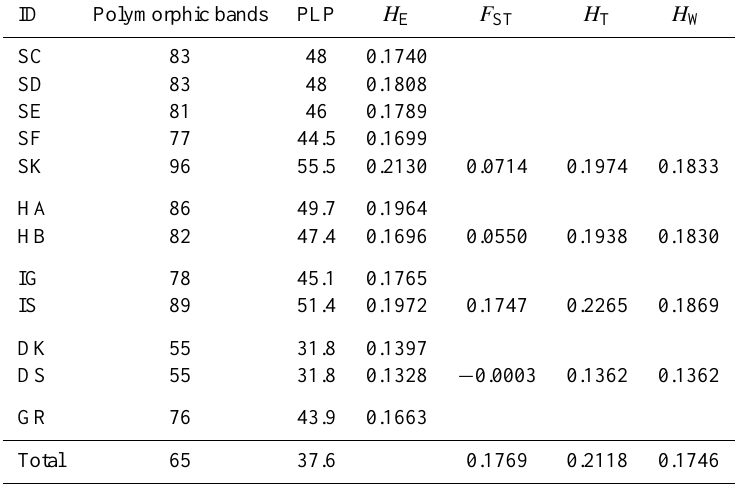
Table 3. Genetic diversity in sampling locations of Honckenya peploides . Total values are for the species, whereas subtotal values are for regions, i.e. Surtsey (SC – SK), Heimaey (HA and HB), mainland Iceland (IG and IS) and Denmark (DK and DS). PLP – percentage of polymorphic loci, H E – expected heterozygosity, F ST – Wright’s F ST , H T - total gene diversity (total heterozygosity), H W – average gene diversity within populations.